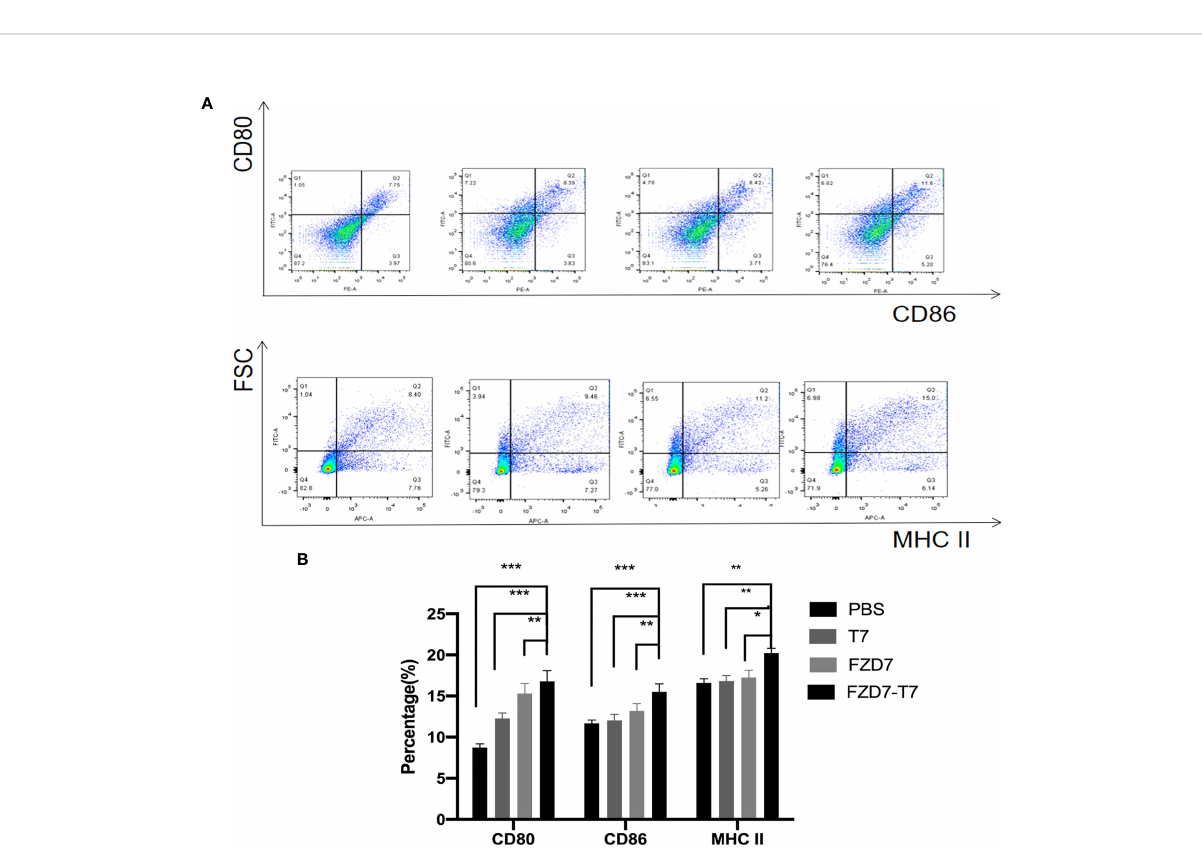
FIGURE 3 Expression of CD80, CD86, and MHC II on the surface of bone marrow-derived dendritic cells detected by fl ow cytometry. (A) Flow cytometry images. (B) Quantitative analysis of fl ow cytometry results. * P < 0.05, ** P < 0.01, *** P <